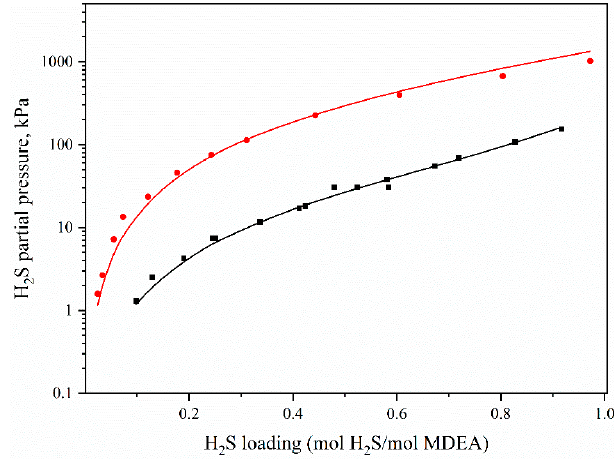
Figure 5. Comparison of the experimental data and calculated data of the H 2 S–H 2 O–sulfolane–MDEA system under different conditions. ■ , measured by Jou et al. [43], T = 313.15 K, MDEA mass fraction = 0.305, sulfolane mass fraction = 0.209; ● , measured by Jou et al. [43], T = 373.15 K, MDEA mass fraction = 0.305, sulfolane mass fraction = 0.209. The solid line represents the calculated data in this work.